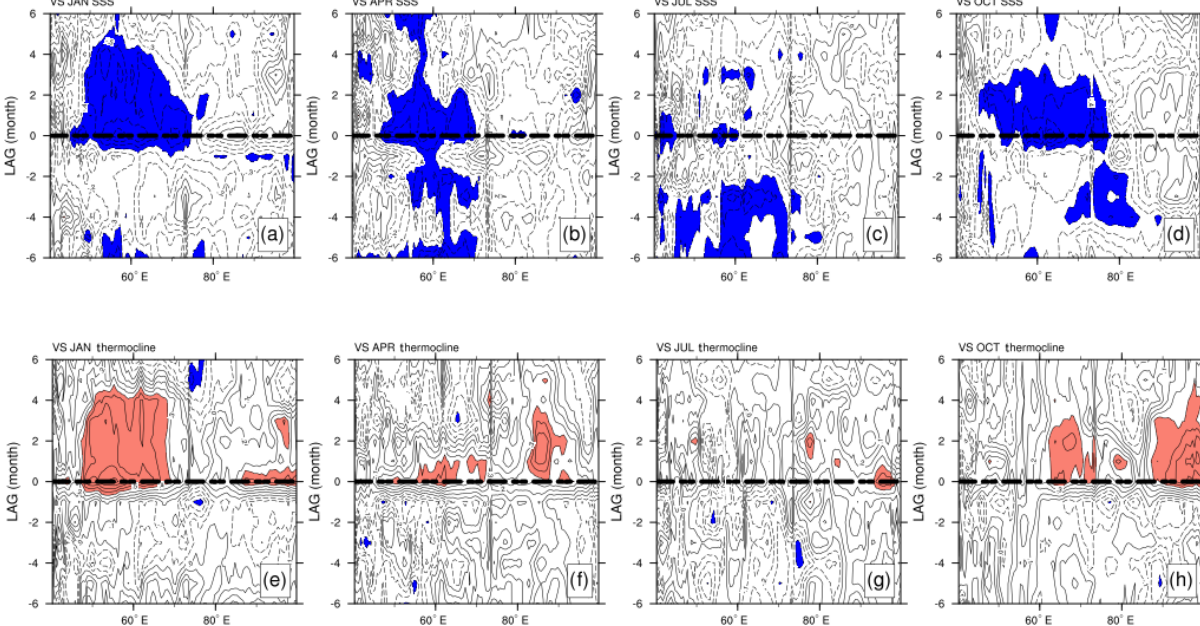
Figure 7. Lead–lag crossing correlations of BLT with SSS (a–d) and thermocline (e–h) anomalies for January (JAN), April (APR), July (JUL), and October (OCT) along the area of 12 ◦ S–5 ◦ N from 1980 to 2015. Shaded areas exceed the 95% significance level. Positive lag means SSS (thermocline) leads BLT, and vice versa. Blue (red) shaded areas represent the negative (positive) correlation. The thick dashed black line represents the in-phase correlation.